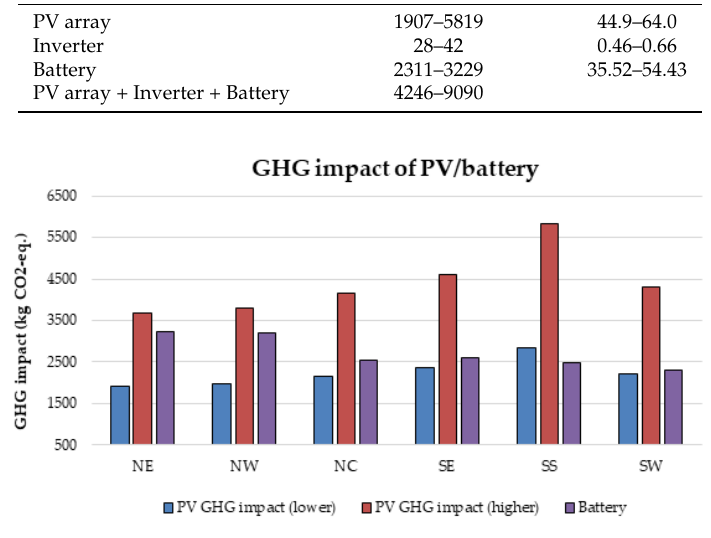
Figure 22. GHG impact of the PV and